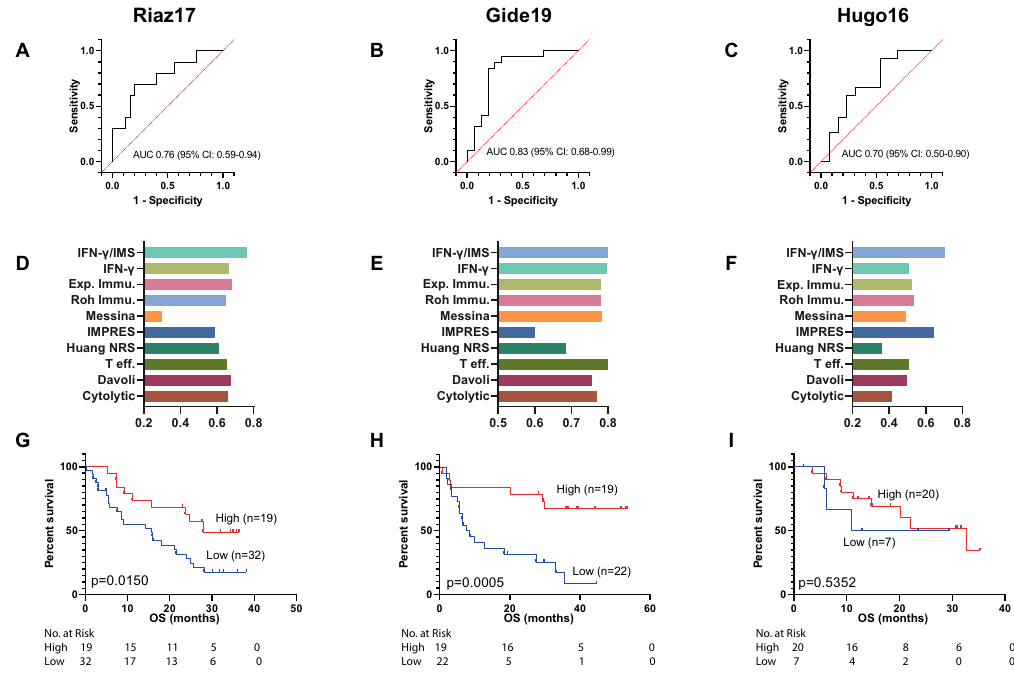
Fig. 4 Ratio of IFN- γ signature to IMS predicts response to ICI immunotherapy on the discovery cohort. A – C ROC curve of sensitivity versus 1-speci fi city for the predictive performance of the IFN- γ /IMS ratio. The AUC values were 0.70 (95% CI: 0.50 – 0.90) for Hugo16, 0.83 (95% CI: 0.68 – 0.99) for Gide19, and 0.76 (95% CI: 0.59 – 0.94) for Riaz17. Patients with SD were not included in AUC calculation. D – F Comparison of the AUC of the IFN- γ /IMS ratio with nine GEP signatures in predicting response to ICI therapy from the literature: IFN- γ , Exp. Immu., Messina, IMPRES, T eff., Davoli, Cytolytic, Roh Immu., and Huang NRS. G – I Kaplan – Meier plots of OS segregated by IFN- γ /IMS with cutoff points selected according to the Youden index on individual with a PR/CR and 4 patients with SD) actually responded. Overall, a higher IFN- γ /IMS ratio was associated with a better ORR ( p = 0.0005; Fig. 5A), OS (HR = 3.45; 95% CI: 0.97 – 12.19; p = 0.0547; Fig. 5D) than a lower IFN- γ /IMS ratio. Compared with IFN- γ